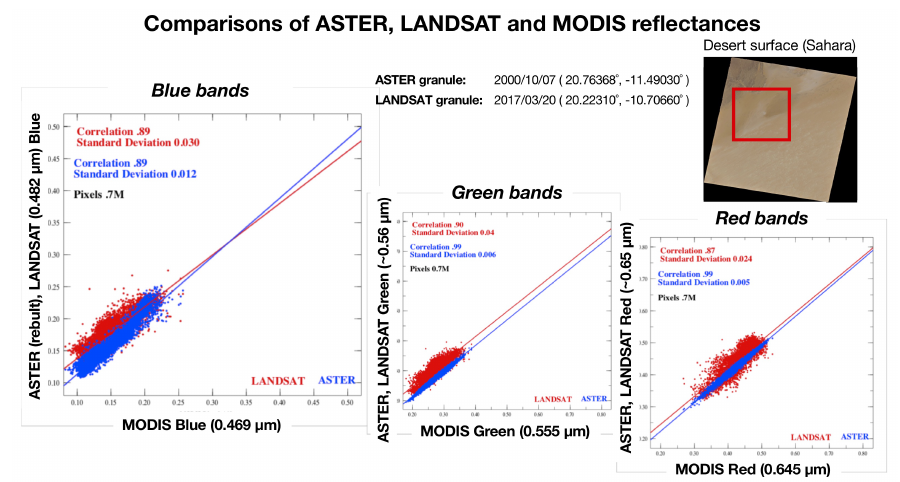
Figure 11. Correlations between ASTER (blue), OLI (red) and MODIS reflectance values (selected within the red box) for the red, green and blue bands over a desert